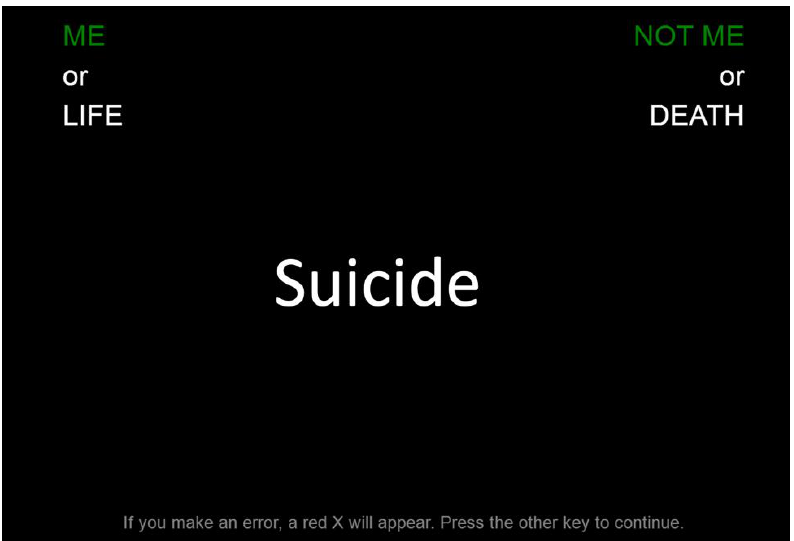
Figure 1. Death IAT Sample Item.